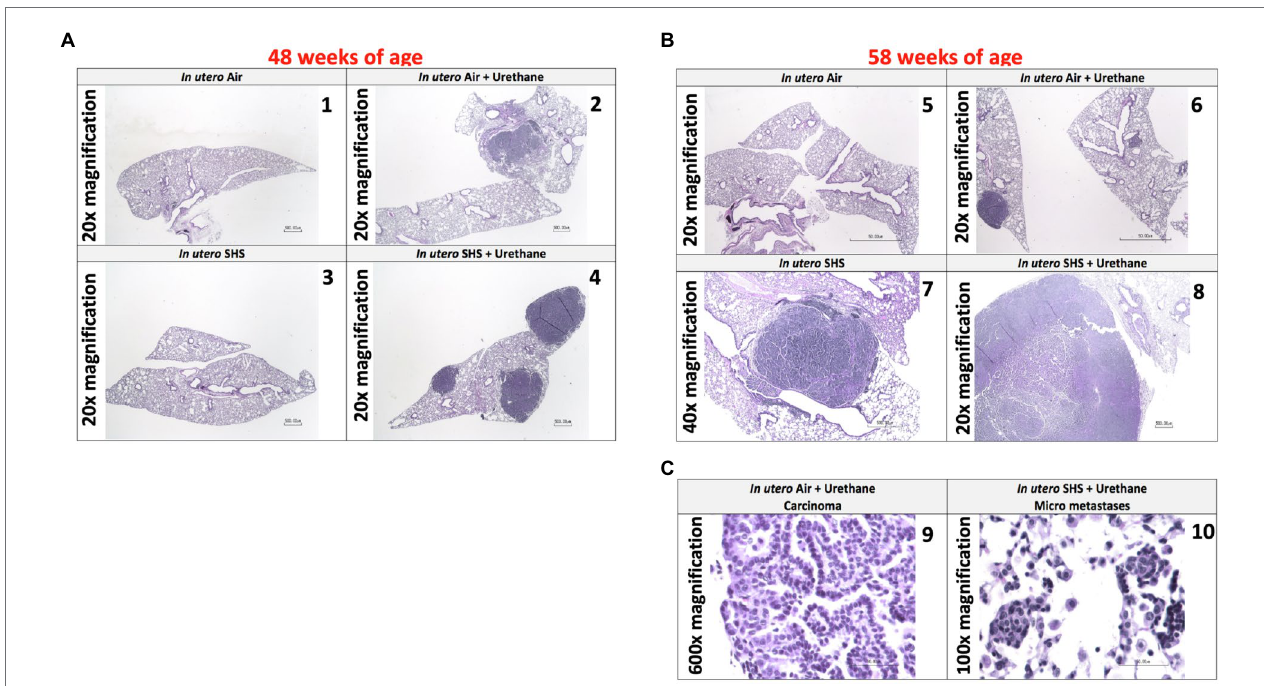
FIGURE 11 | In utero SHS plus adult urethane promoted a tumorigenic microenvironment in the lungs- histopathology assessment. (A) Representative images of H&E stained lung slides from 48-week-old female mouse offspring; 20× magnification. (1) In utero air: normal mouse lung slide; (2) in utero air + urethane: mouse lung slide shows 1 carcinoma; (3) in utero SHS: normal mouse lung slide; (4) in utero SHS + urethane: mouse lung slide shows 3 carcinomas. (B) Representative images of H&E stained lung slides from 58-week-old female mice offspring; 20× and 40× magnification. (5) In utero air: normal mouse lung slide; (6) in utero air + urethane: mouse lung slide shows 1 carcinoma as well as atypical hyperplasia; (7) in utero SHS: mouse lung slide shows 1 adenoma; (8) in utero SHS + urethane: mouse lung slide shows 1 large carcinoma. (C) Representative images of H&E stained lung slides from 58-week-old female mouse offspring. (9) Carcinoma (600× magnification) and (10) micrometastases (100× magnification) are present on the lung slides from in utero air + urethane and in utero SHS + urethane treated mice,